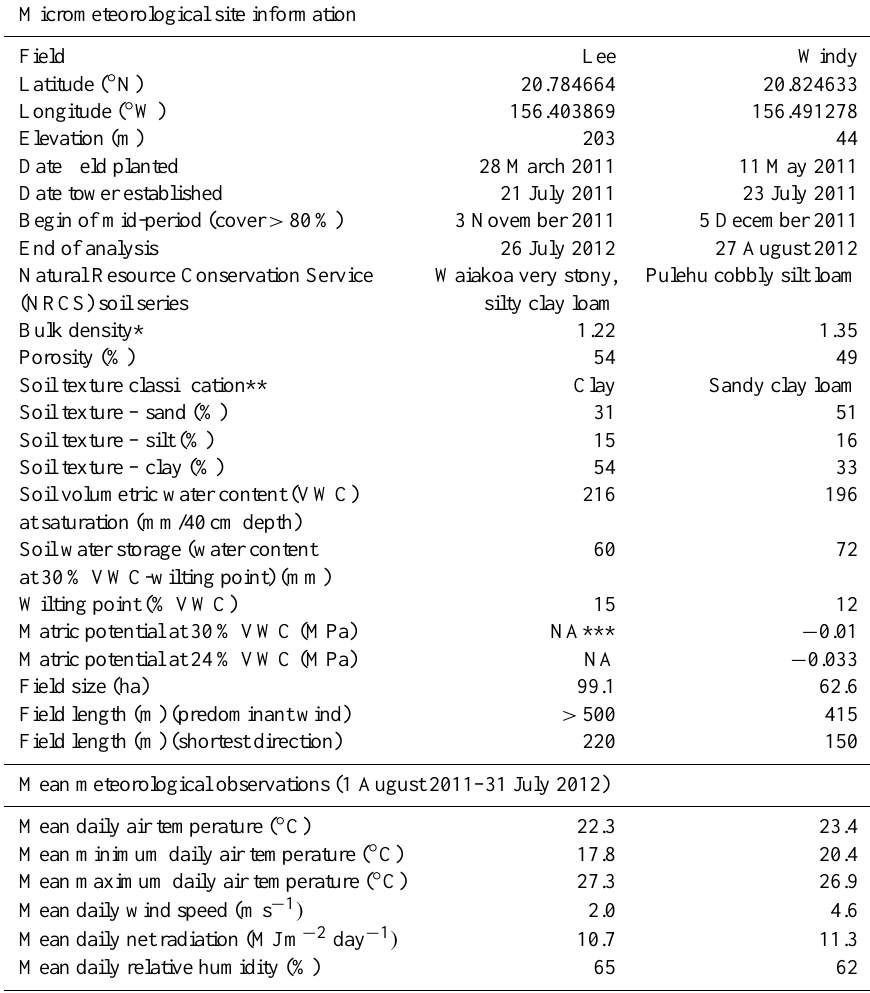
Table 1. Eddy covariance field site